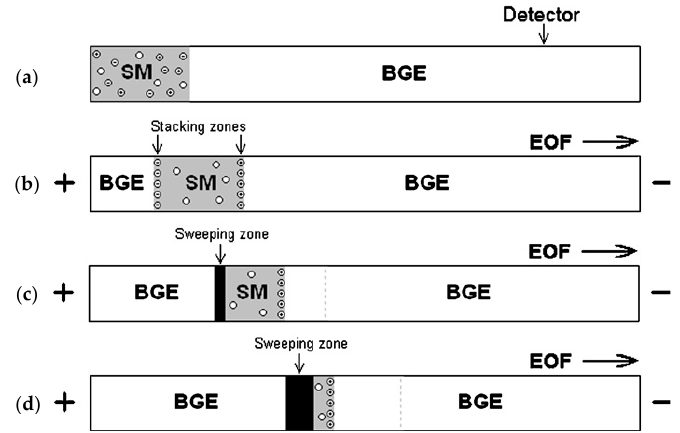
Figure 3. A FASS–sweeping combined mechanism for sample concentration. ( a ) Sample is loaded into the low conductivity sample matrix (SM) which has a lower pH value than the background electrolyte (BGE) that contains anionic micelles. ( b ) Under the effect of an applied voltage, charged analytes are stacked to the two boundaries between SM and BGE, and BGE with micelles enters the anodic end of the capillary by electroosmotic flow (EOF). ( c ) Movement of the micelles into the SM sweep sample compounds. ( d ) All sample compounds are completely swept. ⊖ —Anionic analyte, ⊕ —cationic analyte, ⃝ —neutral analyte. Reprint from Ref. [28]. FASS is the simplest sample concentration technique used in capillary electrophoresis, and pharmaceutical analyses. The readers can have more details from the recent review